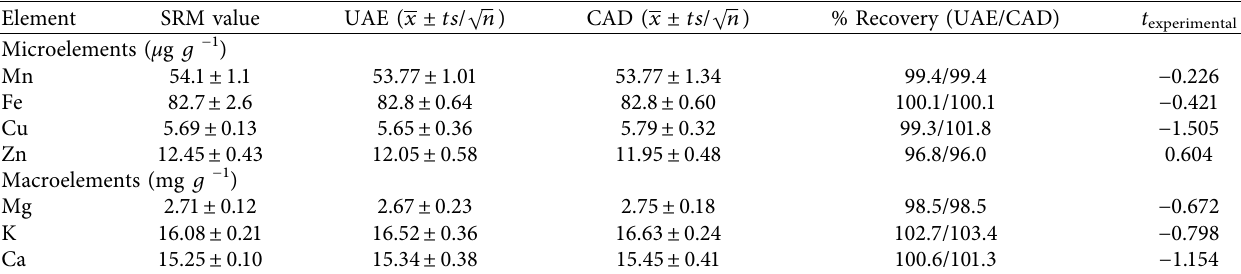
Table 6: Extraction and digestion method validation by using SRM ( n � 6).